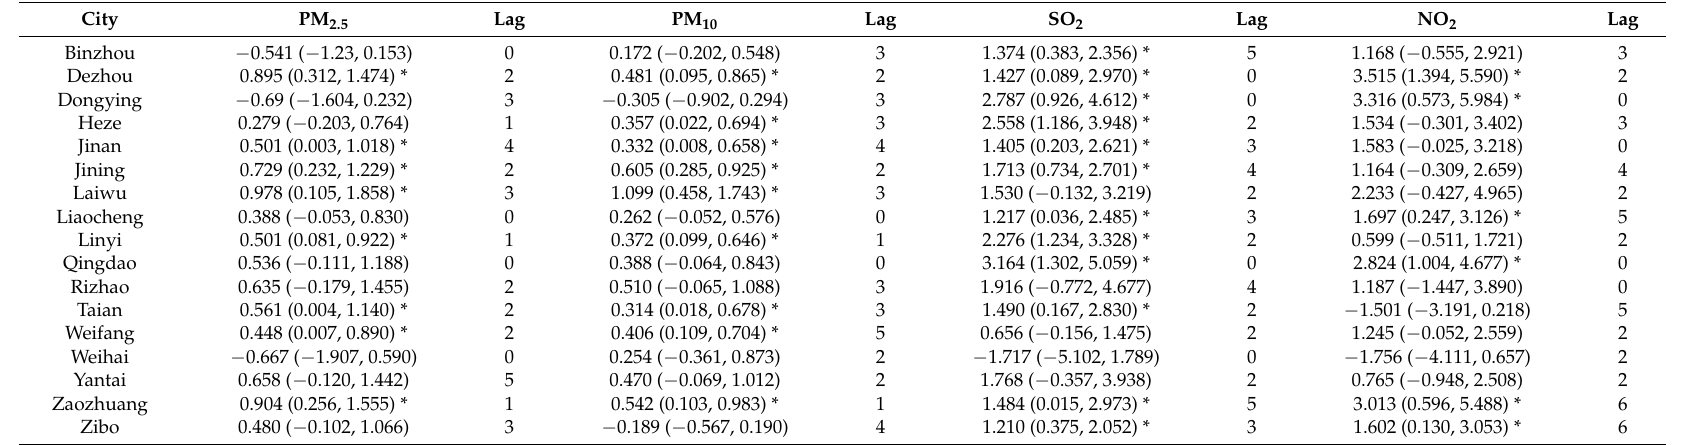
Table 2. The percentage change in the relative risk of the total COPD hospitalizations and its 95% confidence interval (CI) per 10- µ g/m 3 increase in air pollutants in the 17 cities of the Shandong province, where * indicates statistically significant estimates ( p <